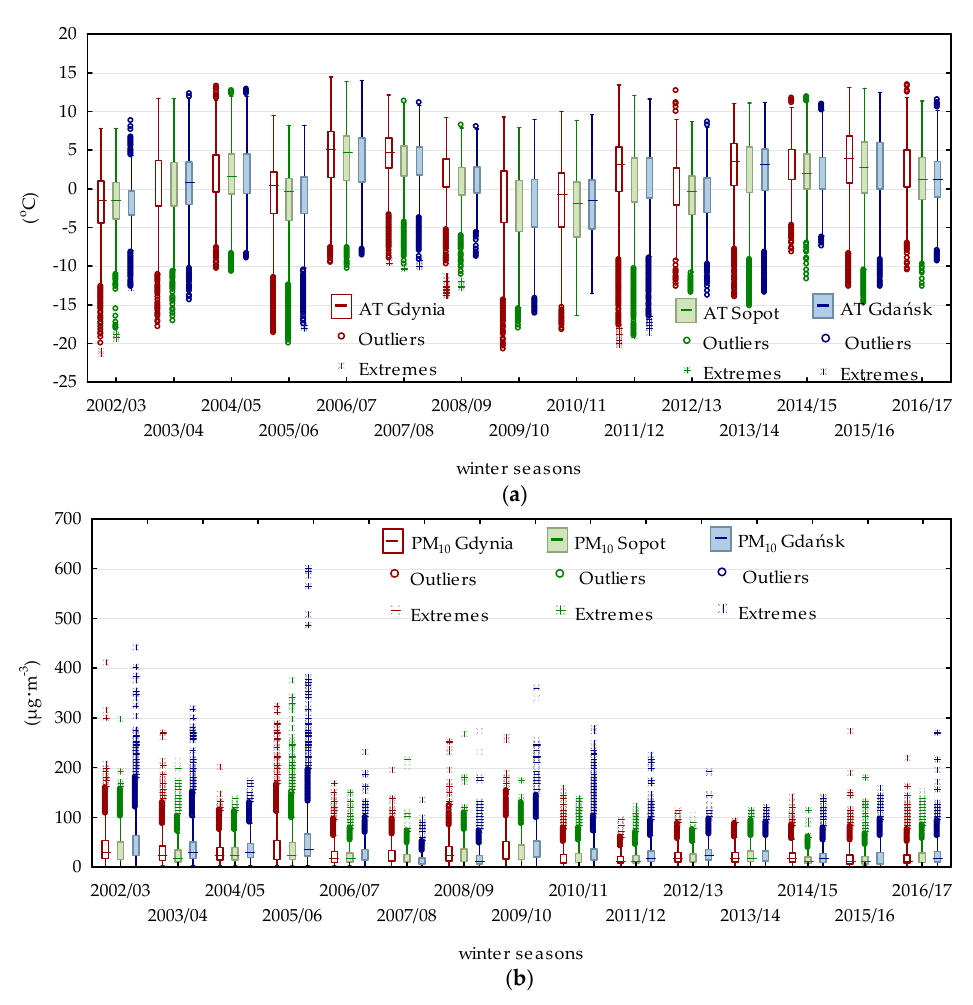
Figure 2. The distribution of the hourly air temperature ( a ) and PM 10 concentrations ( b ) in the Agglomeration of Tricity during the winter seasons (D, J, F) from 2002/2003 to 2016/2017. Notes: the boxes show the 25 th , 50 th , and 75 th percentiles; the whiskers show the non-outlier range. The average hourly PM 10 concentrations in the 15 analysed winter seasons (2002/2003– 2016/2017) (D, J, F) ranged from 26.9 ± 24.9 μ g·m − 3 in Gdynia, 25.1 ± 23.5 μ g·m − 3 in Sopot, and 31.0 ± 32.8 μ g·m − 3 in Gda ń sk. For 75% of the hours, the PM 10 hourly concentrations were lower than 38 μ g·m − 3 in Gda ń sk, 35 μ g·m − 3 in Gdynia, and 32 μ g·m − 3 in Sopot (Table 1). The absolute maximum